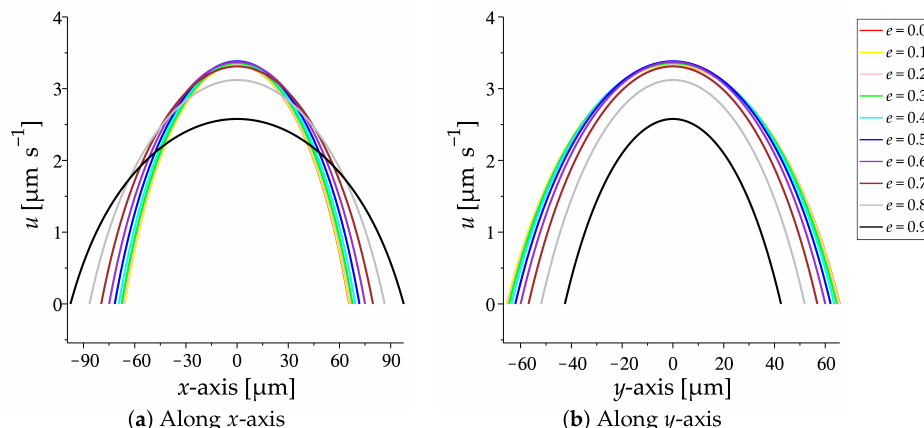
Figure 6. Variation of the velocity profiles of steady electroosmotic flow, when the circumference of the channel cross-sections is fixed, with various eccentricities: ( a ) Along x -axis; ( b ) Along y